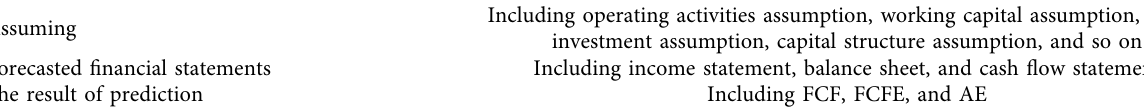
Table 3: Structure table of enterprise valuation model.